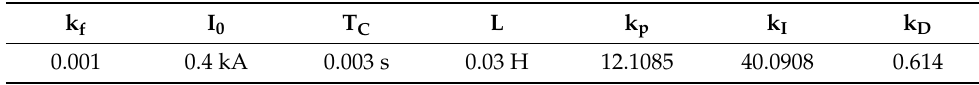
Table A6. SMES model parameters